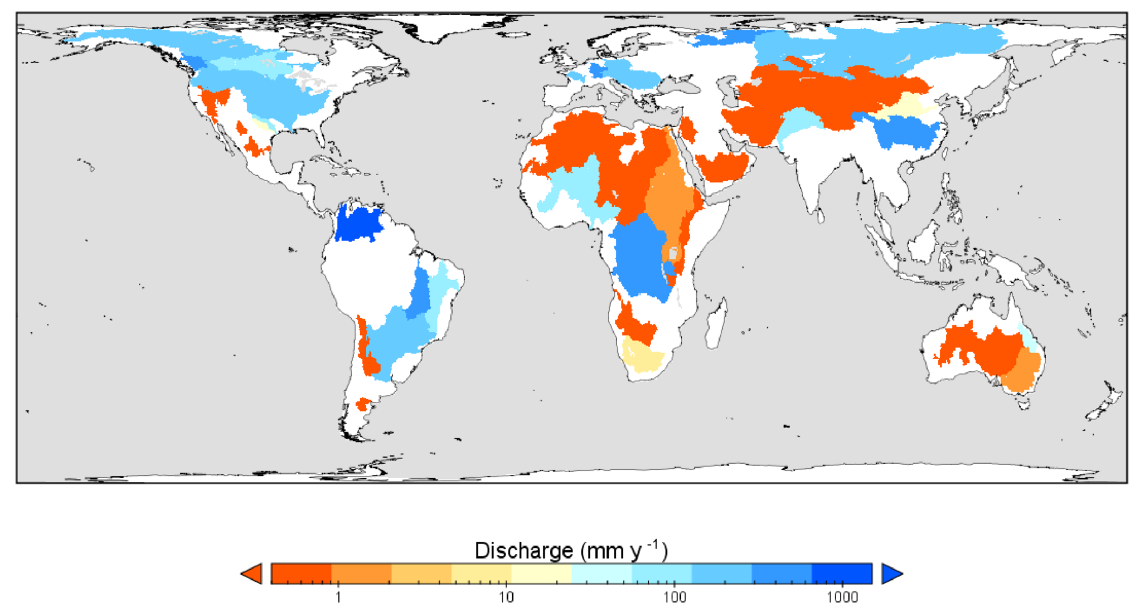
Figure 4. Extent and area-average annual discharge for the 38 ocean-draining (orange to blue) and 13 closed basins (dark orange) used in the evaluation. The two darkest blue colours indicate a discharge in excess of 300mmyr − 1